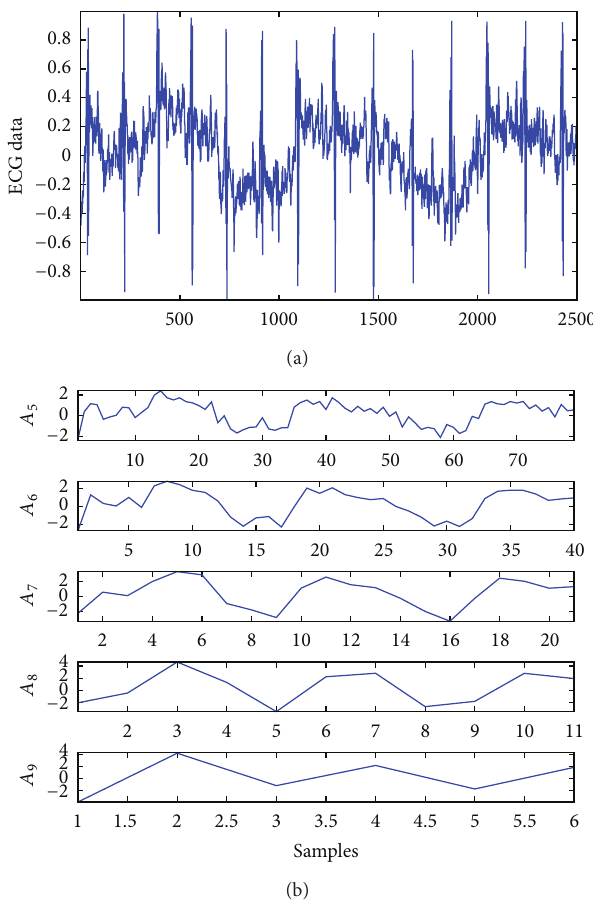
Figure 2: ECG data with BW (lead 4 DaIsy dataset) and approxima- tion sequences at decomposition levels from 5 to 9.